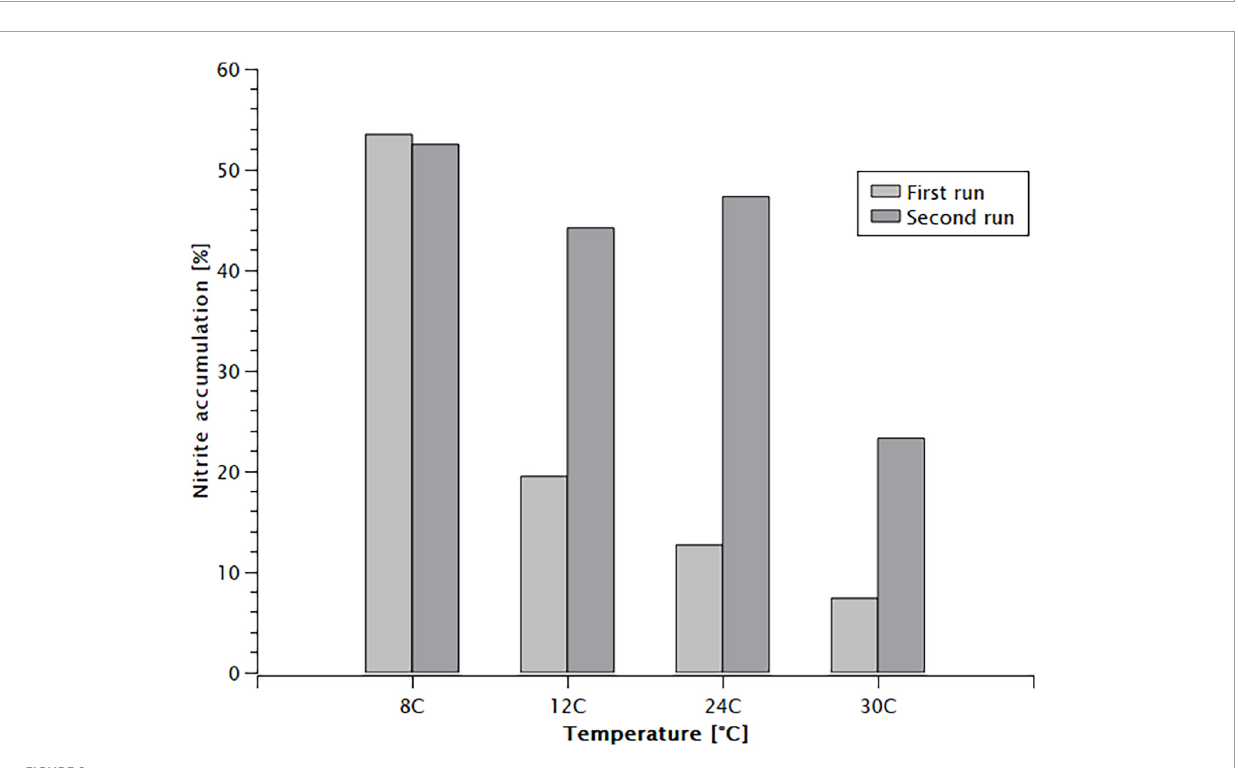
FIGURE2 Nitrite accumulation by the end of the batch